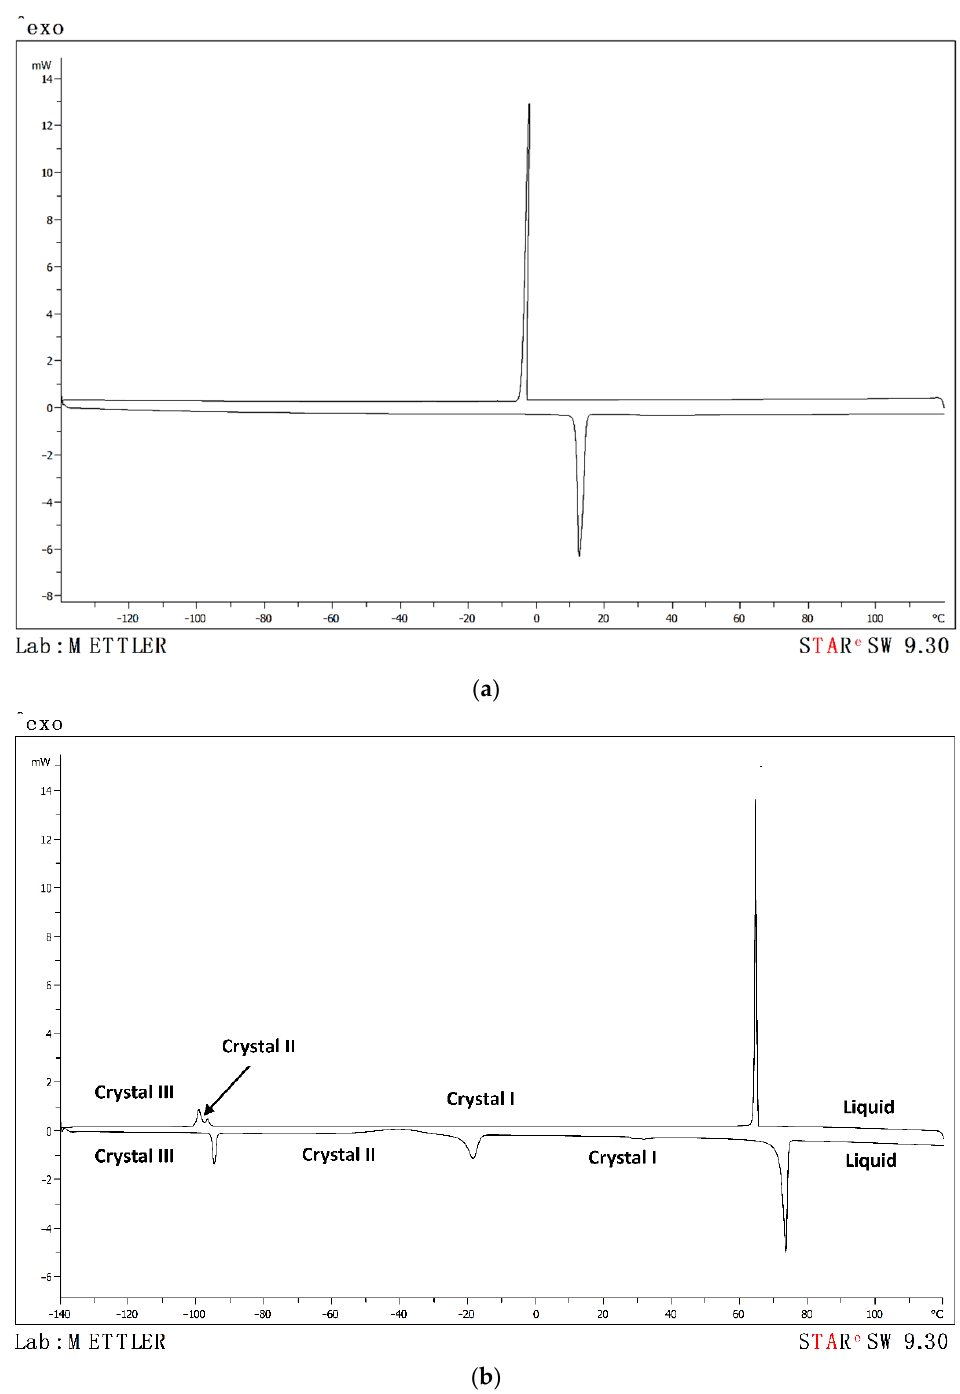
Figure 1. Thermogram cooling the sample from 393.15 K to 133.15 K and heating from 393.15 K